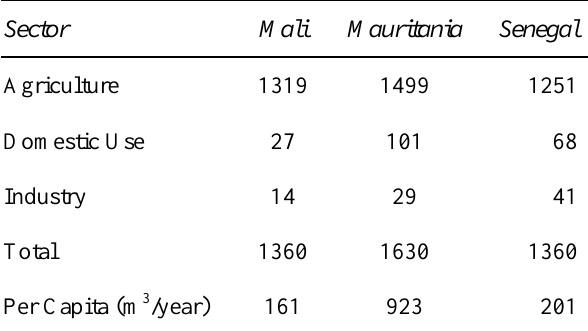
Table 5 : Water use by sector within the OMVS area (in millions m 3 )